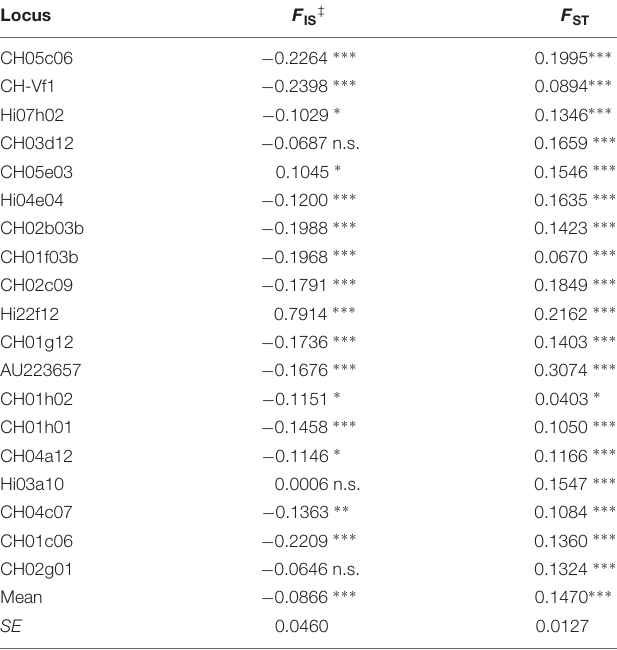
TABLE 6 | F statistics and significance for each locus and total of the 5 groups as obtained by STRUCTURE (SPAGeDi).